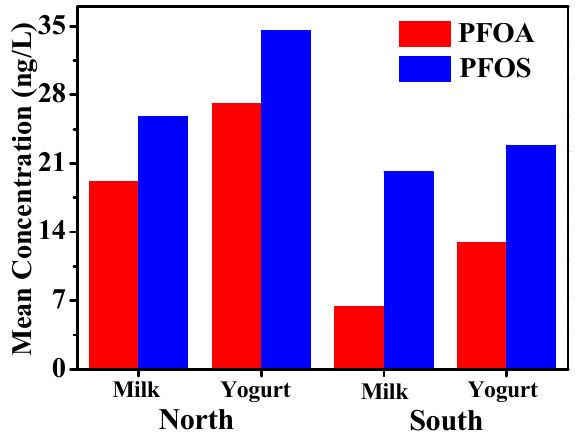
Figure 2. Comparison of mean PFOS and PFOA concentrations in samples from different areas. Table 3. Concentrations (ng/L) of PFOA and PFOS in different areas.